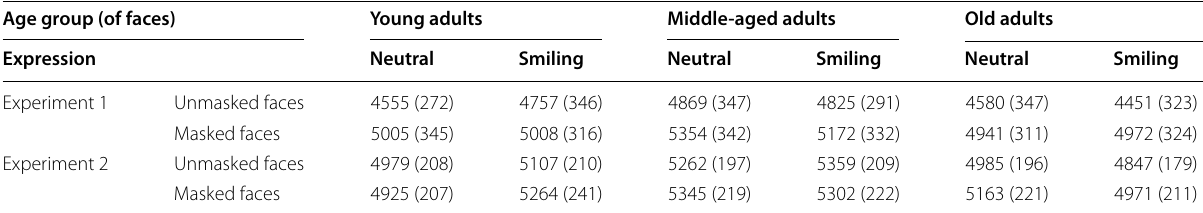
Table 2 Mean response times (in ms) to complete age evaluations of unmasked and masked neutral and smiling faces in the different age groups in Experiments 1 and 2 (standard errors of the mean in brackets) Age group (of faces)